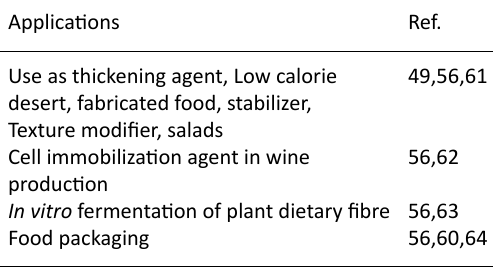
Table 3. Food applications of bacterial cellulose Applications